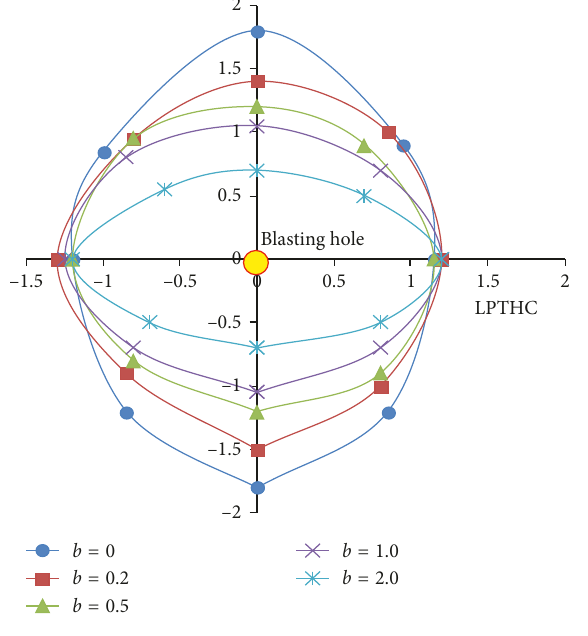
Figure 8: Boundary of the stress-induced crack zone around a blasting hole.